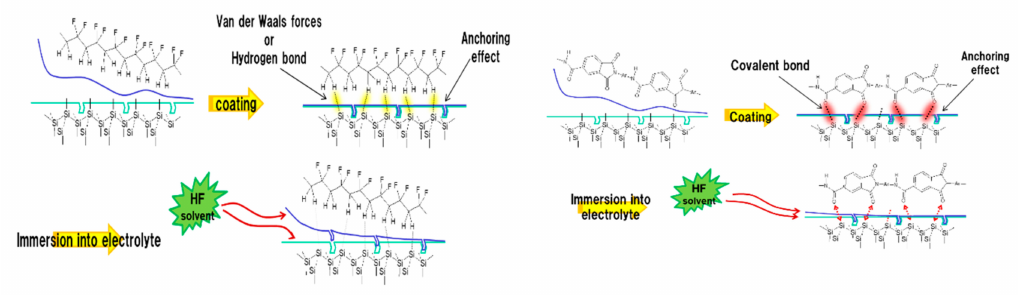
Figure 12. Adhesion image between Si surface and polymers.